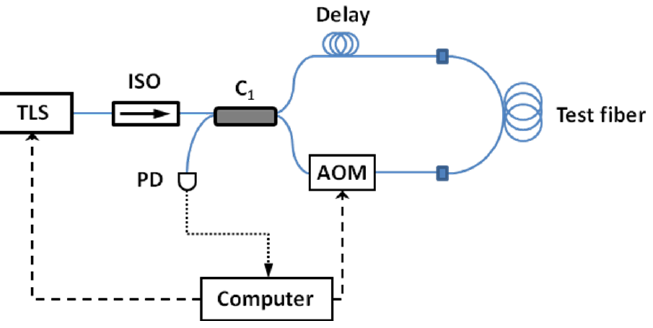
Figure 2. Experimental setup of a frequency-shifted Sagnac interferometer for fiber length and dispersion measurement [30]. TLS: CW tunable laser source; ISO: fiber-optic isolator; PD: photodetector; C : 50/50 fiber direction coupler; AOM: acousto-optic modulator. 1